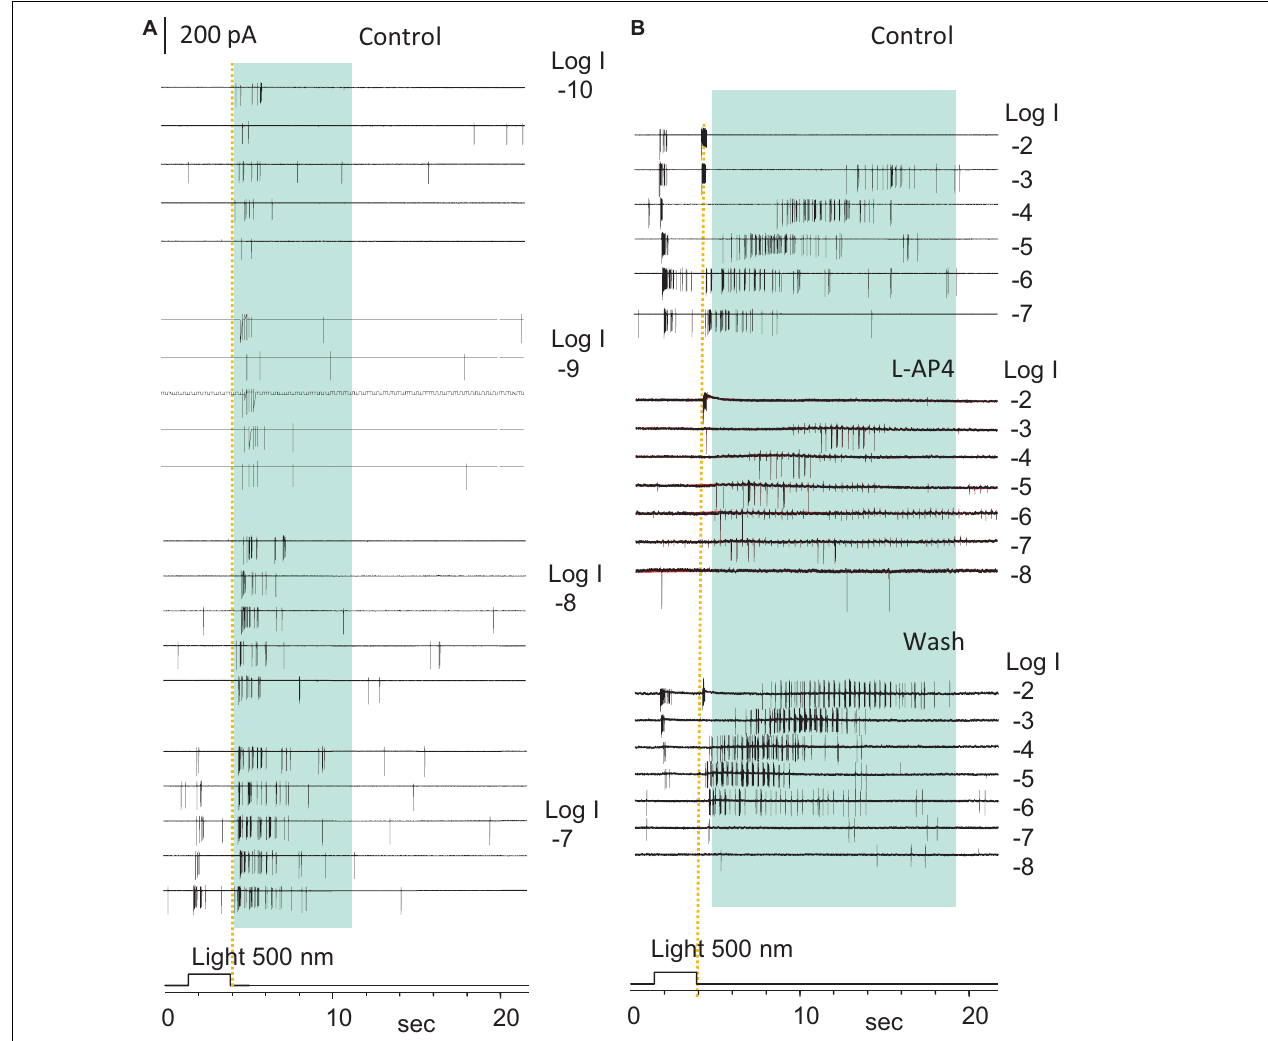
FIGURE 5 | The highly sensitive excitatory rod-driven OFF response in dark-adapted RGCs. (A,B) Action potentials evoked by 500 nm light of a series of intensities (log I) in an ON-OFF retinal ganglion cell (RGCs) under the loose-patch mode. Action potentials are generated at both the light onset and offset, and the cell is identified as an ON-OFF cell. Light offset (yellow dashed line) evokes two spiking patterns, one with the short firing time, low light sensitivity, high firing rate, and short delay (cone-driven), and the other with a long firing period, very high light sensitivity, lower firing rate, and progressively longer delay for brighter light (rod-driven, in blue shaded area in A,B ). The rod-driven OFF responses evoked by dim light (–10 to –6, A,B ) showed a short delay, which is consistent with the delay of the rod Phase 3 at these light intensities in Figure 2E . The spikes at light onset is 3-log-unit less sensitive than those at light offset, which are completely and reversibly blocked by 5 µ M L-AP4 (B) . Spikes after light offset were less robust but maintained a similar pattern in L-AP4, indicating that that the rod-HBC synapse could mediate the highly sensitive excitatory response to light offset. The intensity of unattenuated [0 in log unit (log I)] 500 nm light from a halogen light source was 4.4 × 10 5 photons. µ m − 2 .s − 1